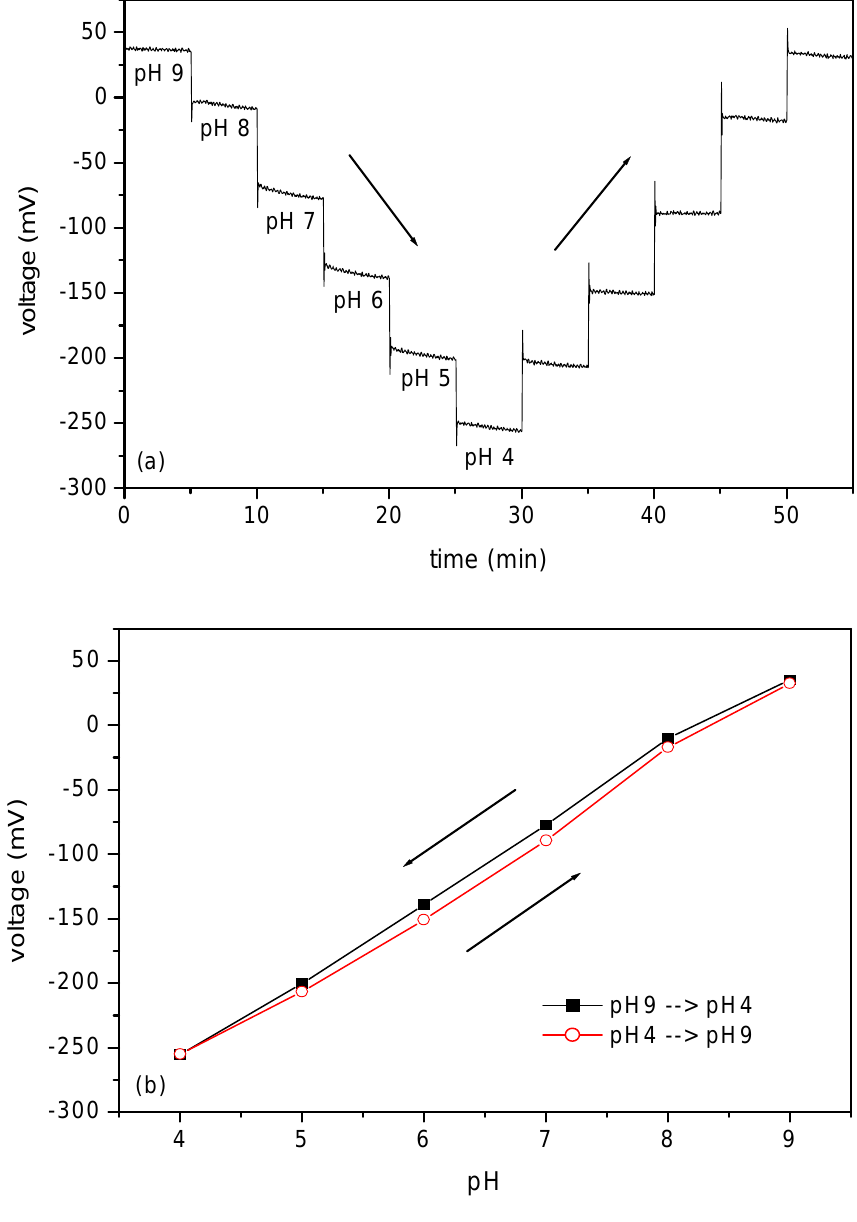
Figure 5. ConCap measurement (a) and corresponding calibration curve (b) of a pH sensor (S2), etched with a current density of 20 mA/cm 2 . The sensitivity was calculated to 59.6 mV/pH (pH 9 (cid:224) pH 4) and 59.1 mV/pH (pH 4 (cid:224) pH 9) after the sensor has been measured for several times and stored in de-ionised water for 44